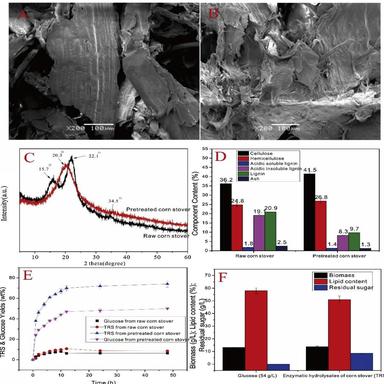
A, B: SEM morphologies for raw and pretreated corn stovers; C, D, E: Comparative WXRD patterns, components and enzymatic hydrolysis of raw and pretreated corn stovers; F: Comparative study of lipid production by R. toruloides Y4 using glucose (54 g L−1) and enzymatic hydrolysates of corn stover (TRS 54 g L−1) as carbon source. Pretreated corn stovers refer to corn stover treated by /DMSO (XILs = 0.2) at 140 °C for 2 h and regenerated by methanol.